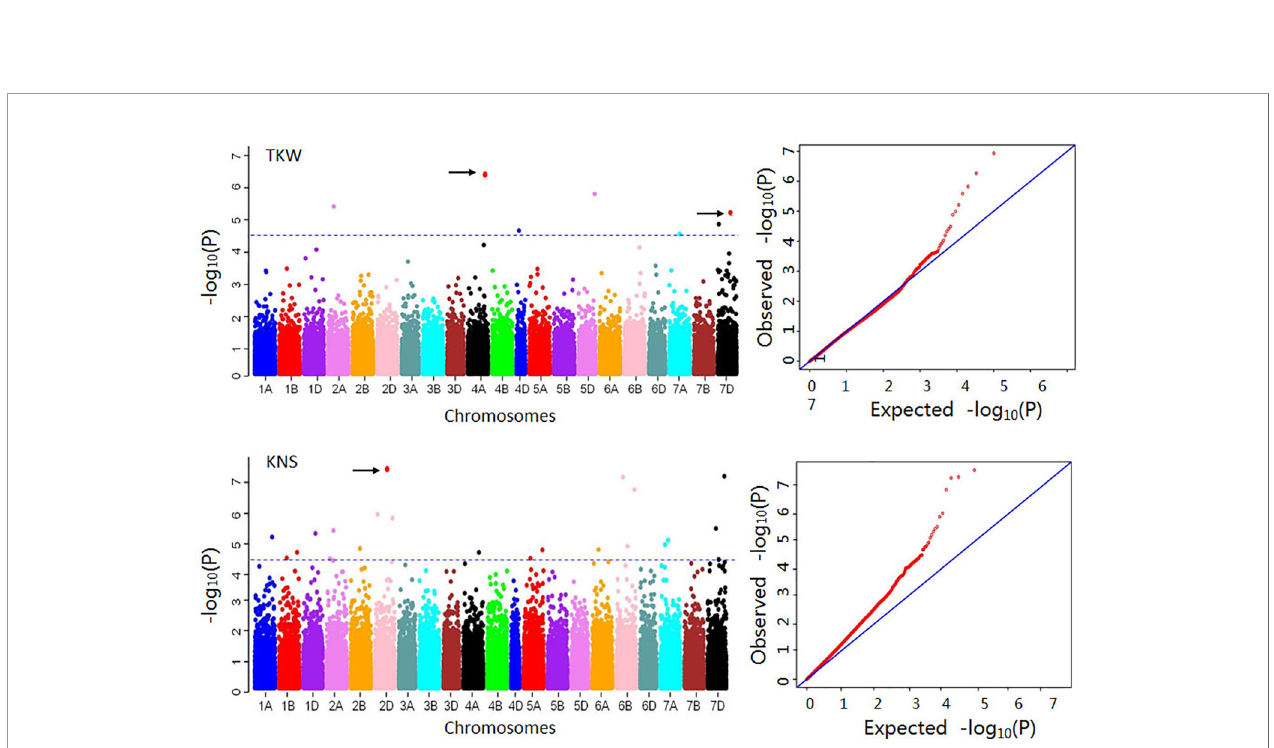
FIGURE 2 | Manhattan and Q-Q plots for 1,000-kernel weight (TKW) and kernel number per spike (KNS). The blue horizontal line indicates threshold for signi fi cance. For TKW, the red dots on 4A and 7D represent markers AX-111600193 and AX-108838800, which showed positive effects in 12 and 10 environments, respectively. For KNS, the dot on 2D represents the marker AX-110982403, which showed a positive effect in 15 environments.